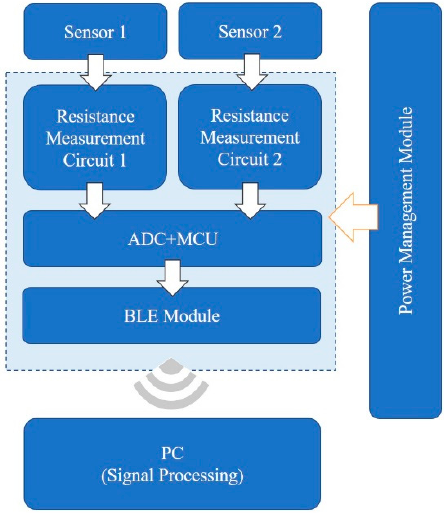
Figure 2. System flow diagram.